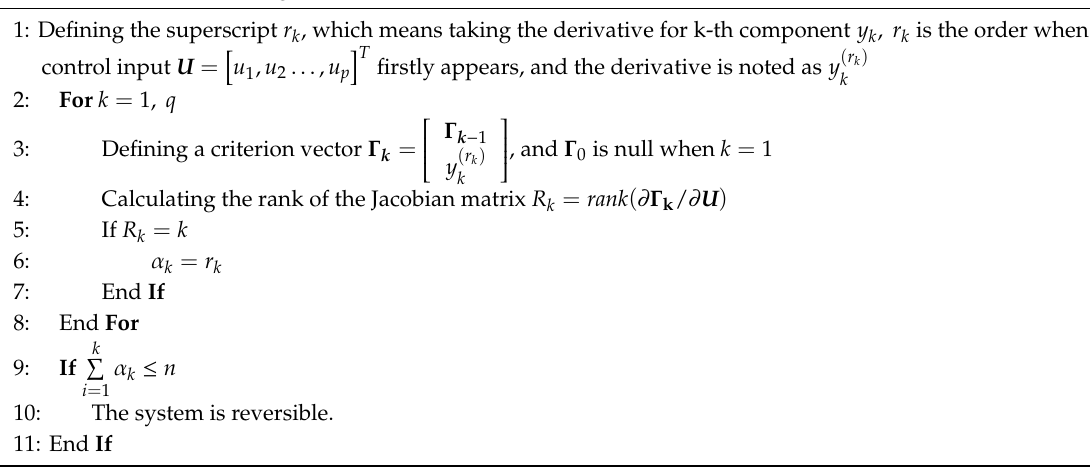
Algorithm 1. Interactor